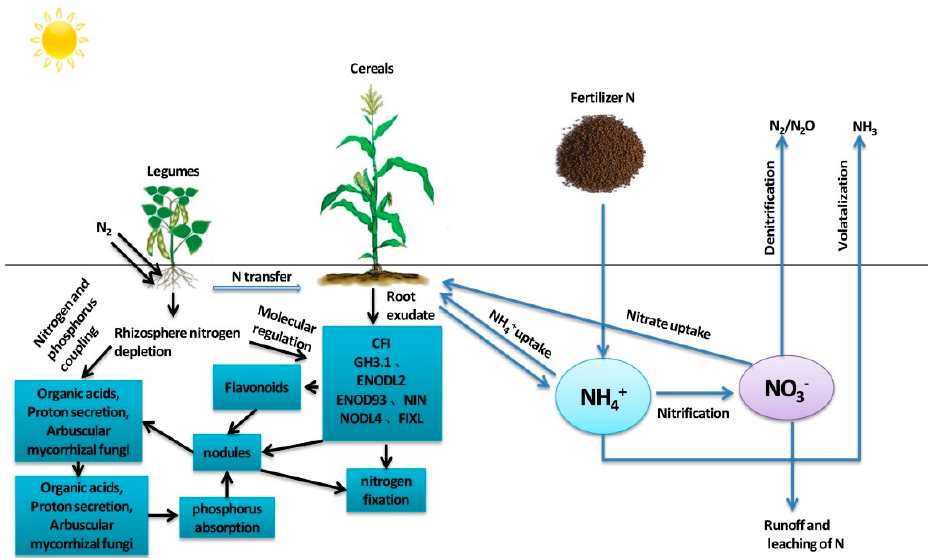
Figure 1. Nitrogen transfer and distribution in the legume–cereal intercropping system.